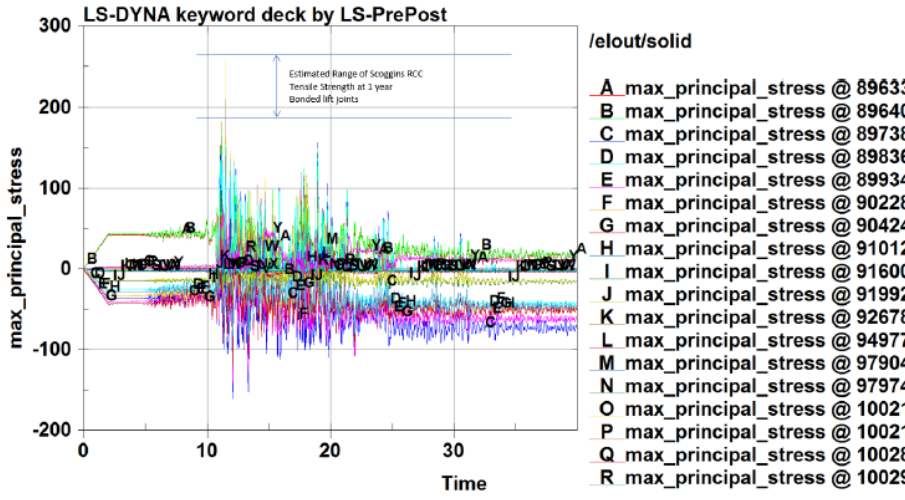
Figure 8. Example stress response of various nodes along the upstream face of monolith 15 during the 5000-year Short Duration MYG008 Earthquake. Max_principal_stress shown on vertical axis is in psi (145 psi = 1 MPa). Note that positive stress on the vertical axis is tension, and negative stress on this axis is compression. Units of the horizontal scale are seconds.